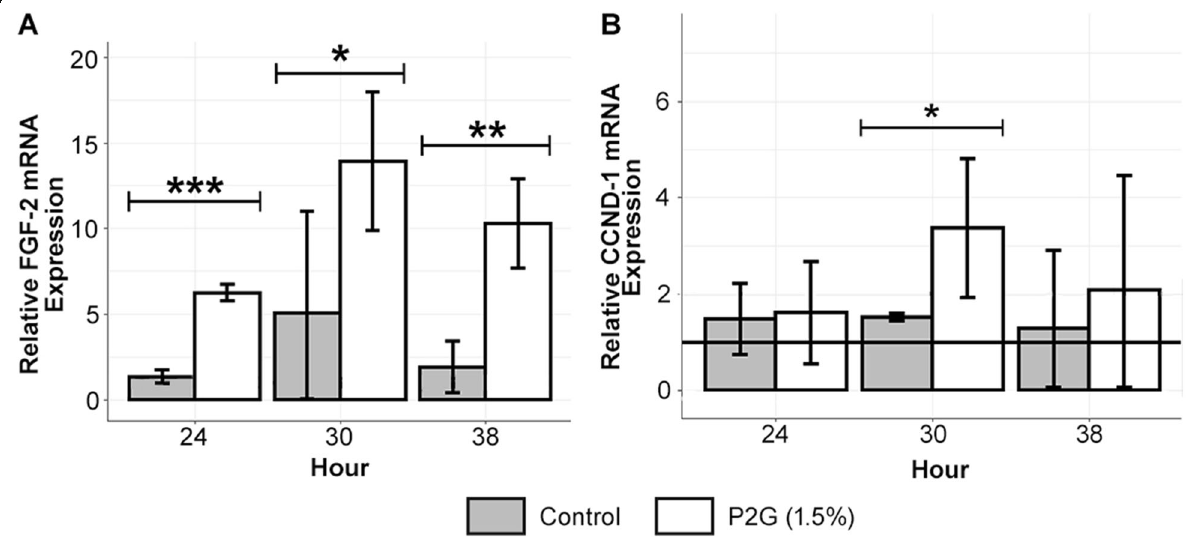
Fig. 1 P2G (1.5%) upregulates FGF-2 and CCND-1 mRNA expression in preosteoblasts. a Experimental data indicate that relative to water controls, chondrocytes treated with P2G exhibit increased levels of FGF-2 at hours 24, 30, and 38 (Welch ’ s t -tests). At hour 30, numerical Welch ’ s t -test result of a statistically significant difference between means takes precedence over the small visual overlap between treatment and control error bars. b P2G (1.5%) upregulates CCND-1 (Cyclin D) mRNA expression at hour 30 in preosteoblasts (fold increase of 2.23, directional Welch ’ s t -test on Experiment 2 data). The solid line is the normalized mean of hour 0 pre-treatment baseline measurements. Control refers to study arms treated with water. The graph displays qRT-PCR mRNA expression. NS p > 0.05, * p < 0.05, ** p < 0.01, *** p <